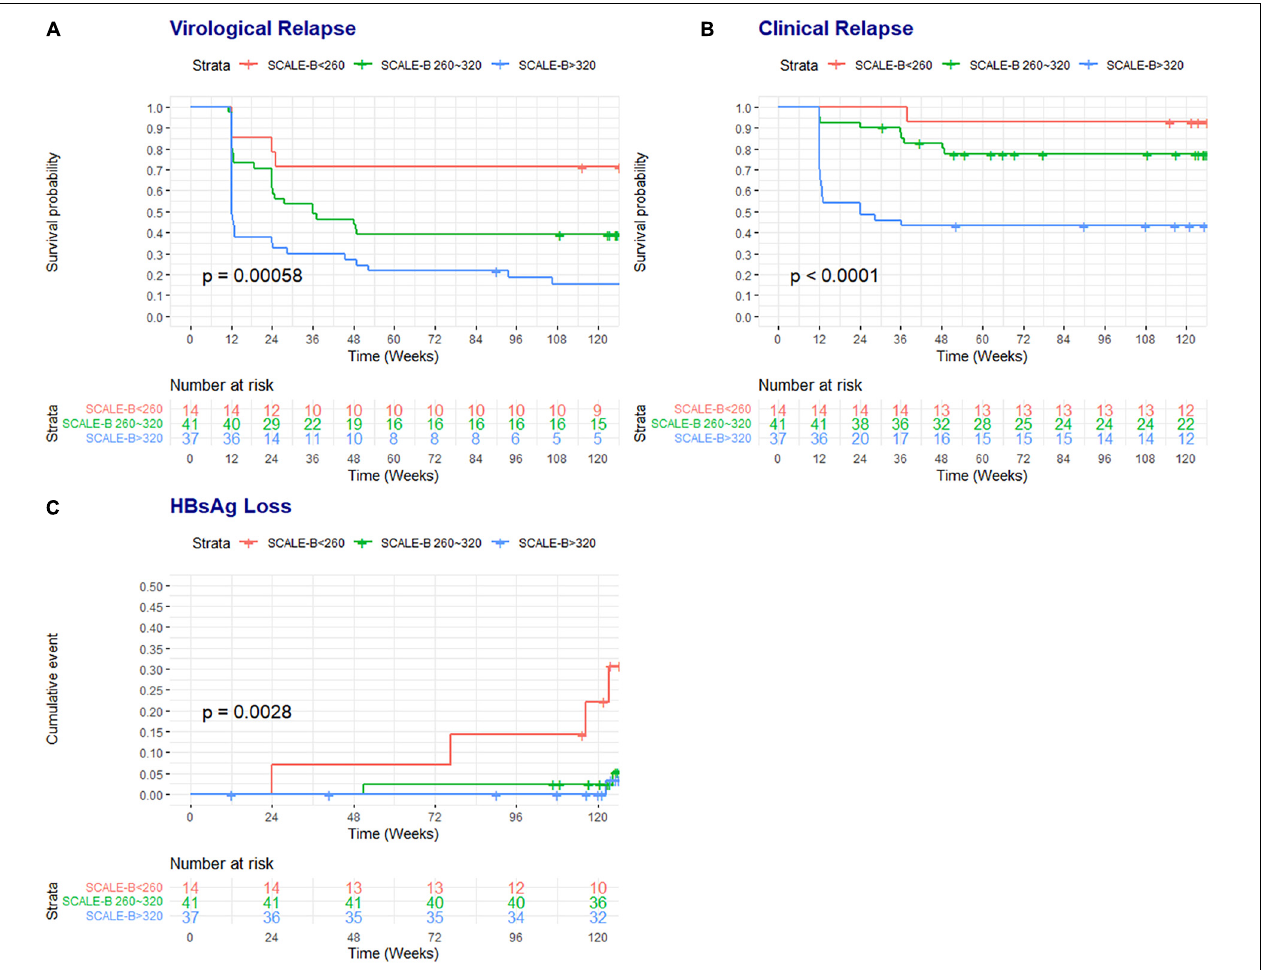
FIGURE 2 | The survival probability of patients free of virological relapse and CR and the cumulative rates of HBsAg loss according to the SCALE-B strata. (A) Virological relapse, (B) CR, and (C) HBsAg loss. SCALE-B scores were calculated as HBsAg (log 10 IU/ml) + 20 × HBcrAg (log 10 U/ml) + 2 × age (year) + ALT (U/L) + 40 for the use of tenofovir, where HBsAg level (S), HBcrAg (C), age (A), ALT (L), and tenofovir (E) use for HBV (B) treatment. The SCALE-B score is divided into three groups: low SCALE-B score ( < 260 points), intermediate SCALE-B score (between 260 and 320 points), and high SCALE-B score ( ≥ 320 points).